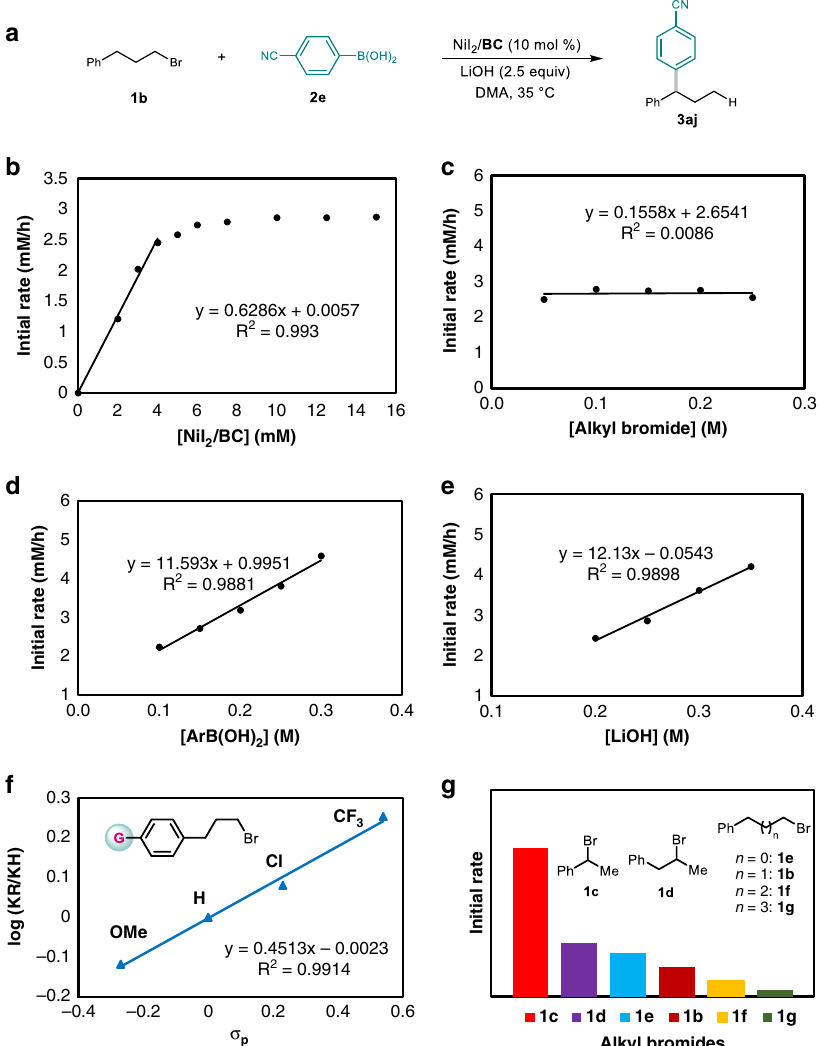
Fig. 5 Kinetic pro fi les. a Model reaction. b Reaction order in catalyst concentration. c Reaction order in alkyl bromide concentration. d Reaction order in aryl boronic acid concentration. e Reaction order in base concentration. f Hammett plots of alkyl bromides. g Initiate reaction rate of different alkyl